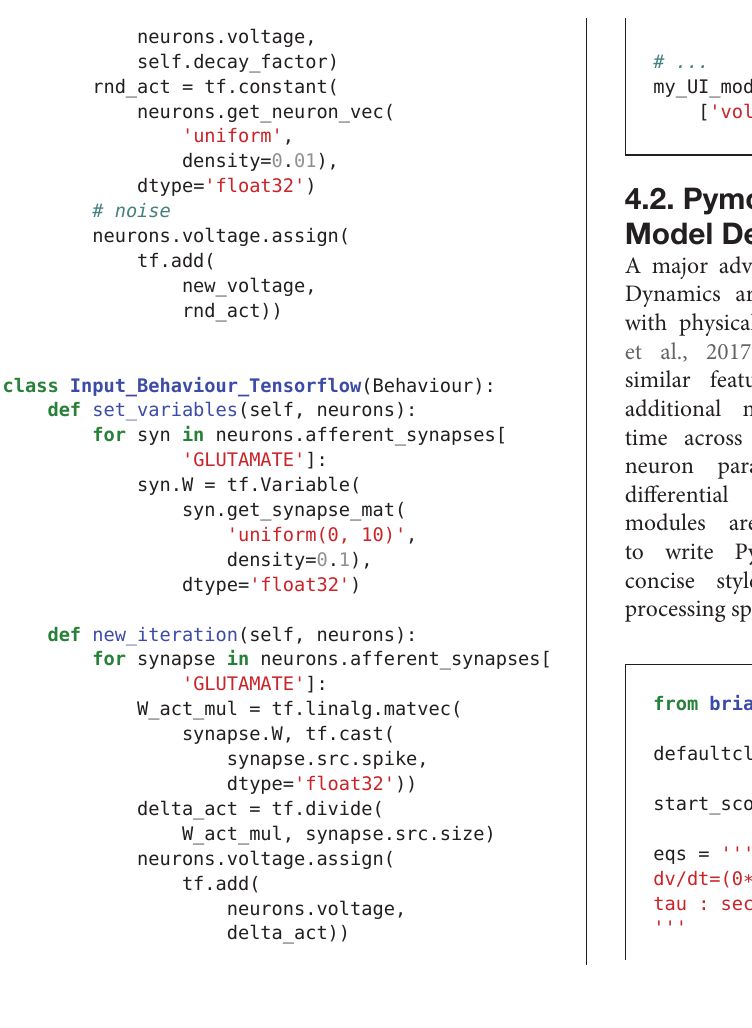
neurons.voltage,